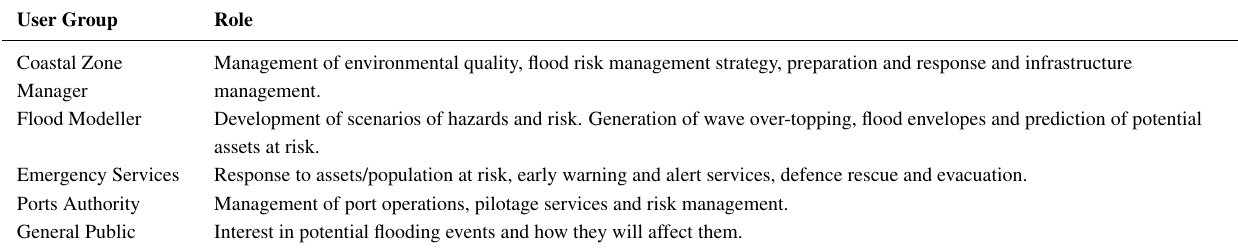
Table 3. User groups for the flood web